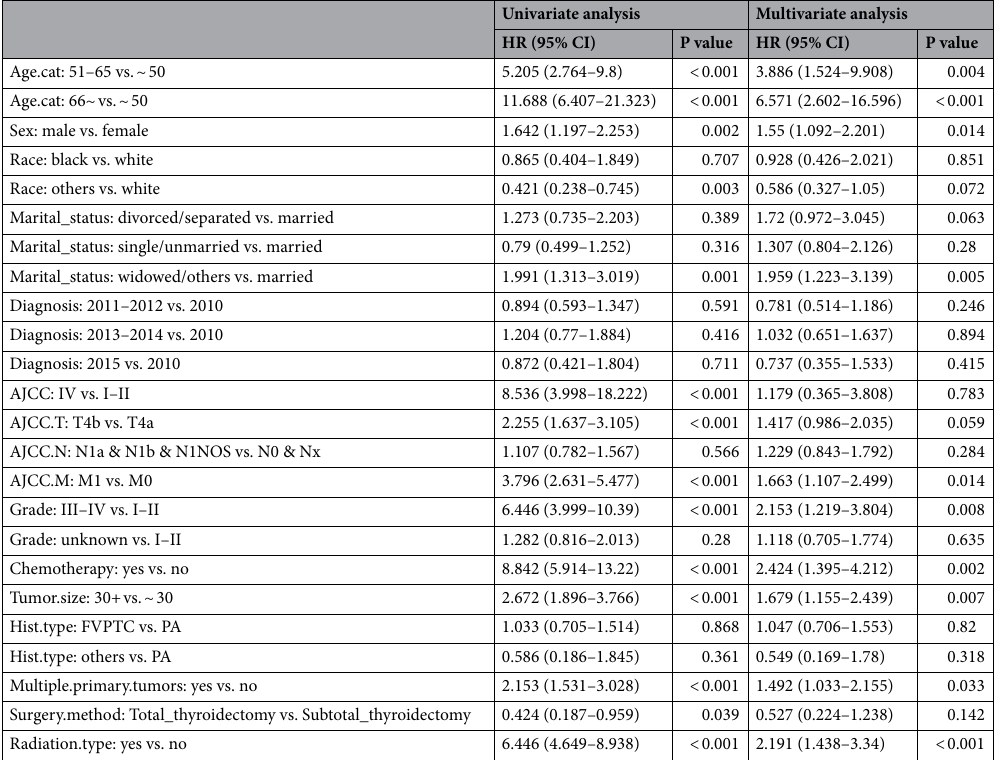
Table 2. Cox regression: univariate and multivariate analyses of overall survival. Age: age of diagnosis, Sex: sex, Race: ethnic group, Marital status: marital status, Diagnosis: time of diagnosis, AJCC: AJCC